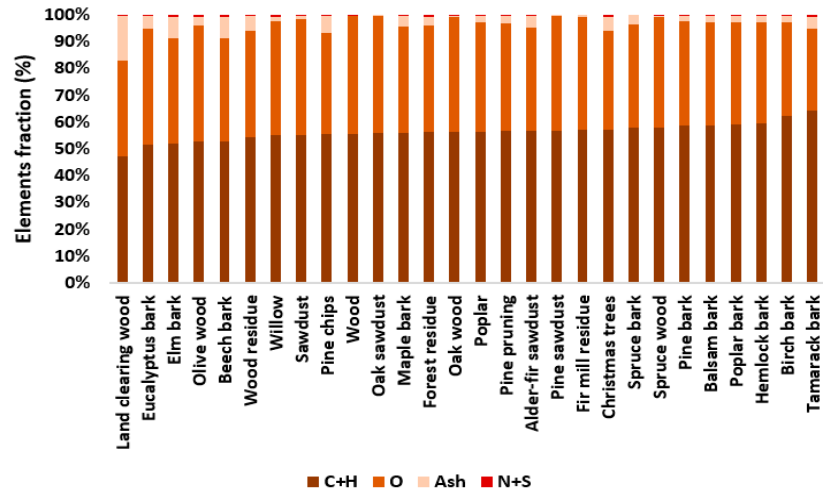
Figure 4. Percentage shares of composing elements for different WB&FR.